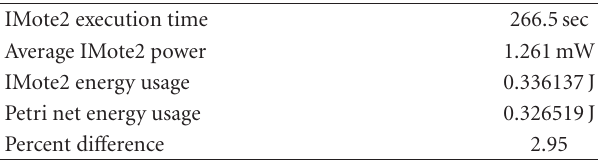
Table 8: Petri net transition parameters for a simple system.